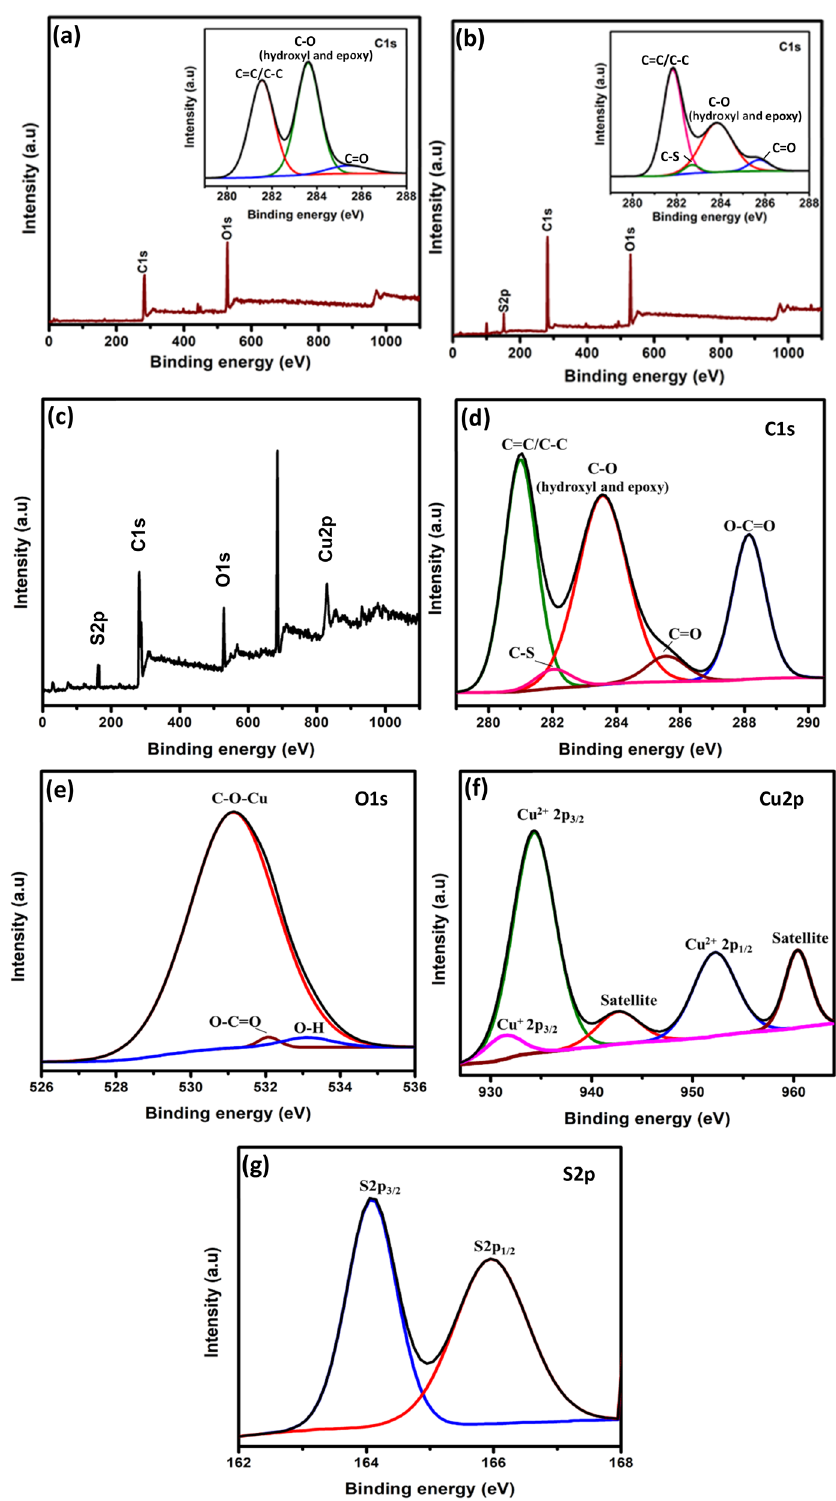
Figure 3. Wide scan XPS spectra of ( a ) GO (inset: high resolution C1s), ( b ) PrGO (inset: high resolution C1s) and ( c ) PrGO/HKUST-1. High resolution ( d ) C1s, ( e ) O1s, ( f ) Cu2p and ( g ) S2p of